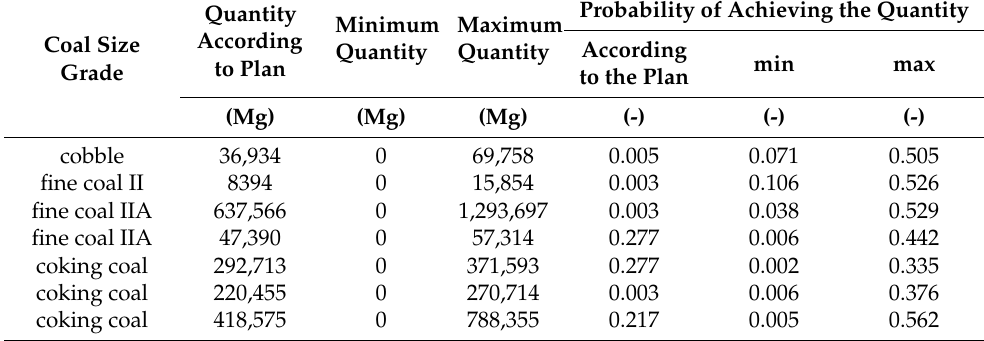
Table A13. A summary of the volumes of sales of the individual coal grades with the probability of their achievement at σ yprog for mine